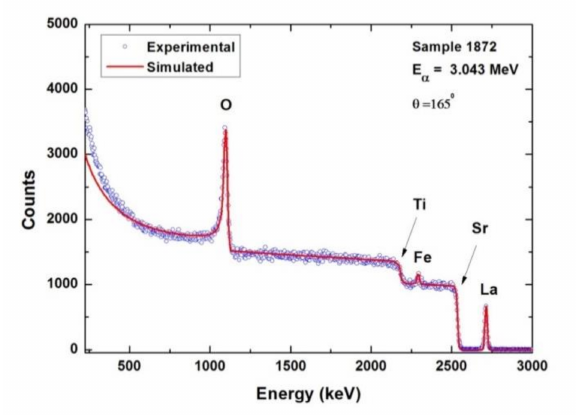
Figure 14. Representative RBS spectrum and simulation result recorded on 14 nm LFO/STON